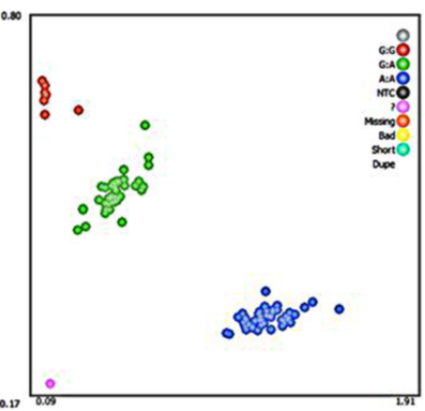
Table 4. Association of genotypes of MAP3K5 (g.205261 A > G) with body size